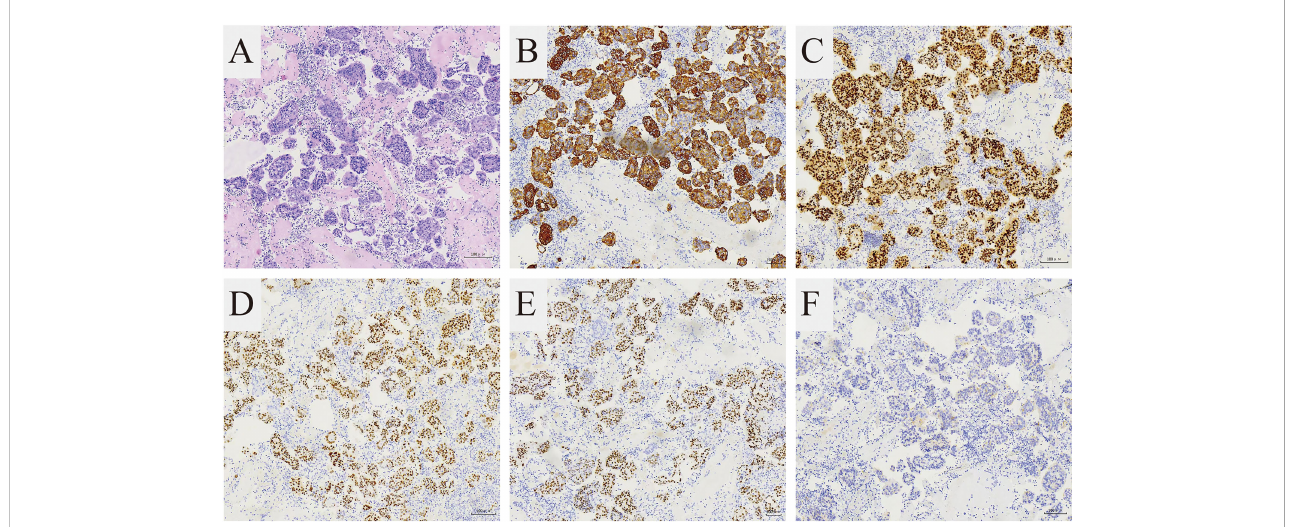
FIGURE 2 Pathological features of the cell blocks of the pleural fl uid. (A) The H and E stain showed that the tumor is composed of small round cells (magni fi cation 100×). The immunohistochemical stain showed (B) CK7 (+) and (C) GATA3 (+) supporting breast cancer metastasis (magni fi cation 100×). The immunohistochemical stain showed (D) ER (+), (E) PR (+), (F) HER-2(1+) representing Luminal A subtype (magni fi cation 100×).